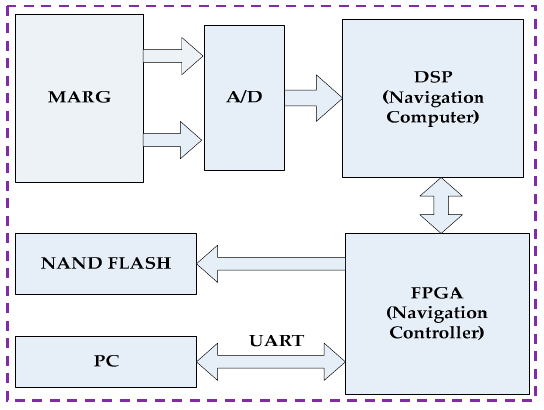
Figure 5. Structural diagram of the AHRS.